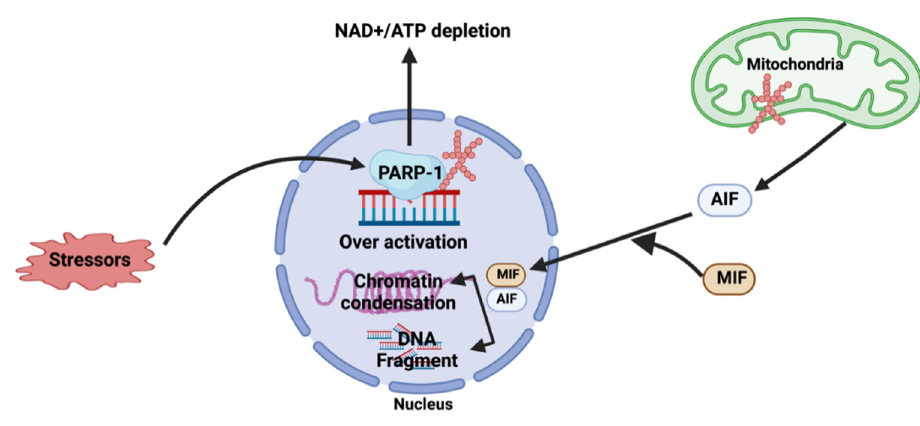
Figure 4. The roles of PARylation in parthanatos. PARylation is vital in the main signaling pathway of parthanatos. AIF, apoptosis-inducing factor; MIF, macrophage migration inhibitor factor. This figure was created using BioRender.